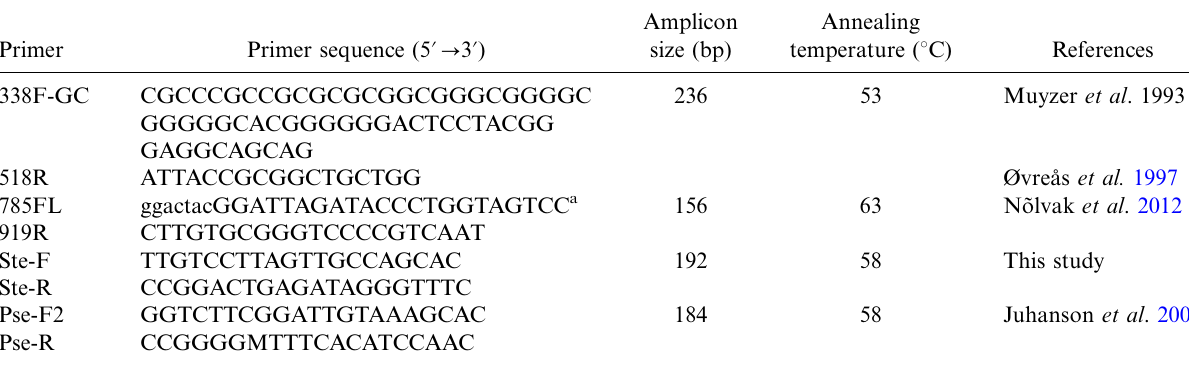
Table 3. Characteristics of PCR primers used in DGGE and quantitative PCR methods